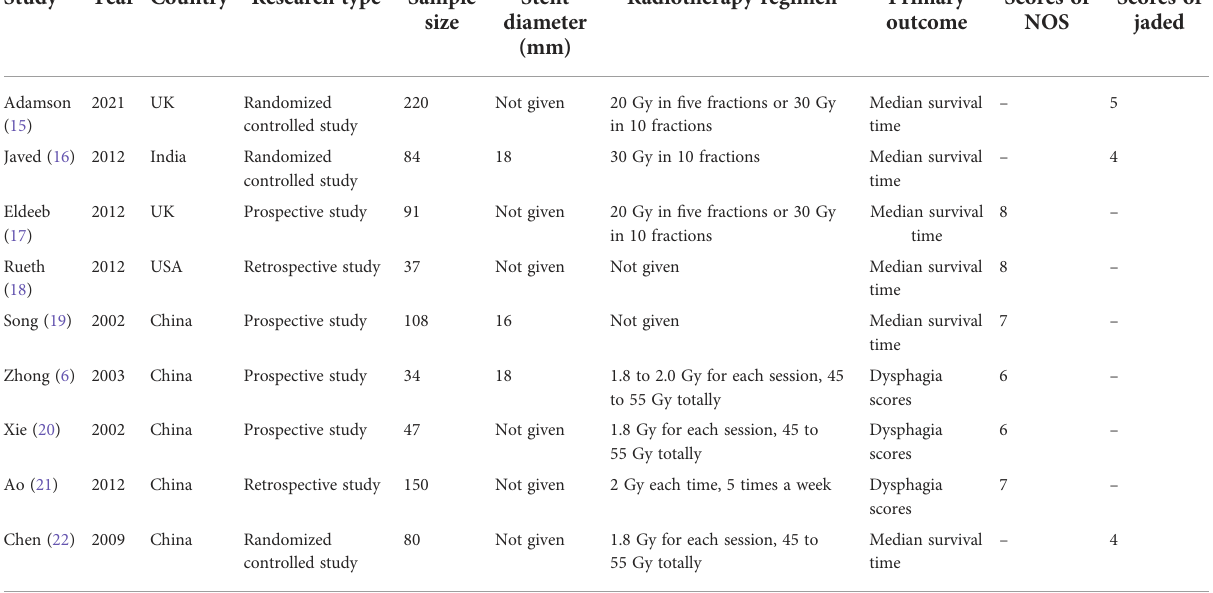
TABLE 1 Summary of the identi fi ed nine